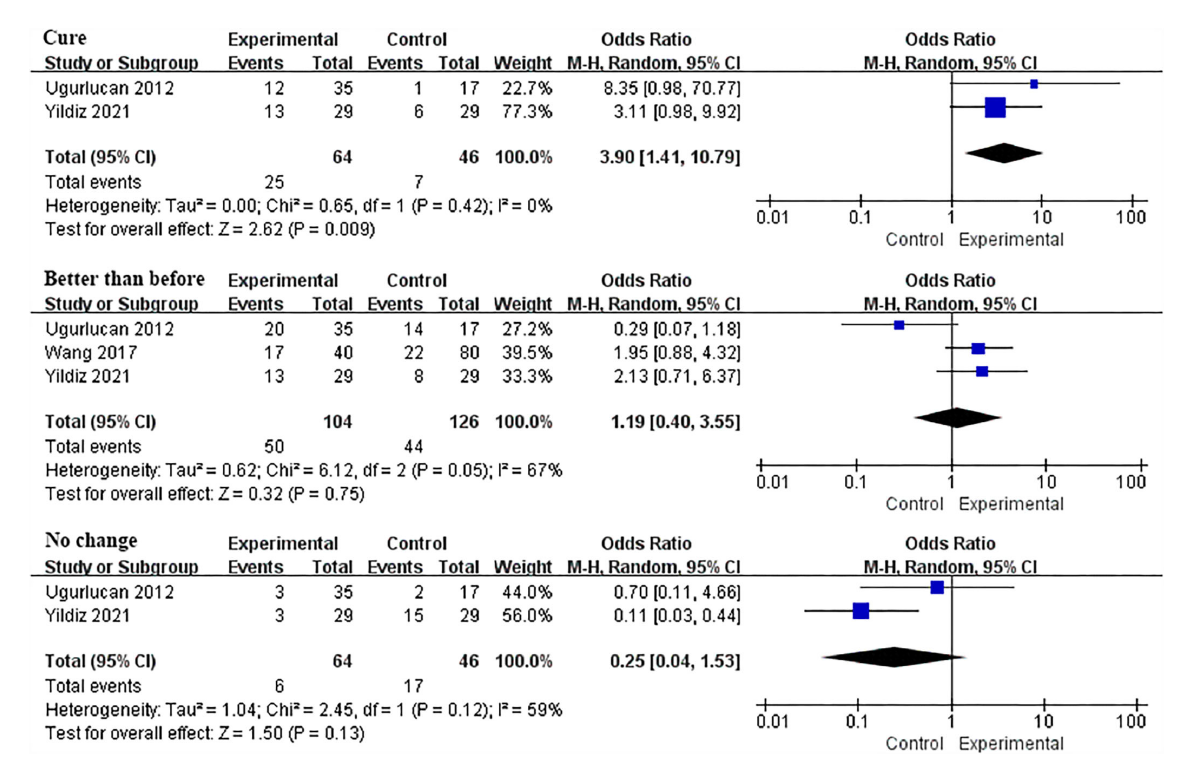
FIGURE9 Forest plots showing the changes in patients’ subjective feelings after IVES treatment. M–H, Mantel–Haenszel; CI, confidence interval; df, degrees of freedom.